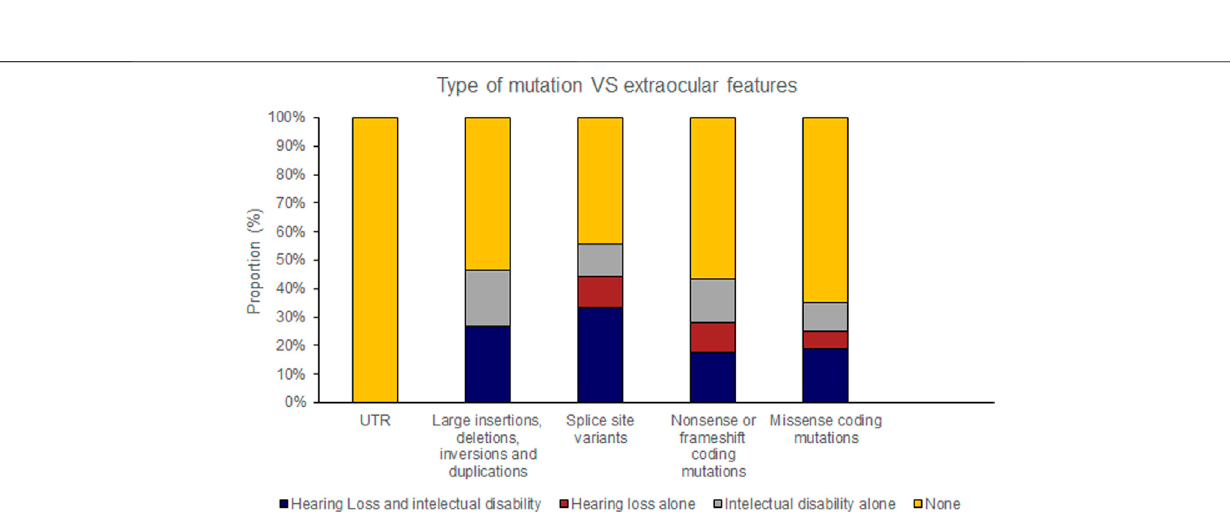
FIGURE 7 | Pathogenic variants ( ‘ mutations ’ ) were classi fi ed by type (UTR [untranslated region], large insertions, deletions, inversions and duplications, splice site variants, nonsense or frameshift coding mutations and missense coding mutations). The proportion of mutations of each type that caused extraocular features (hearing loss or intellectual disability) is